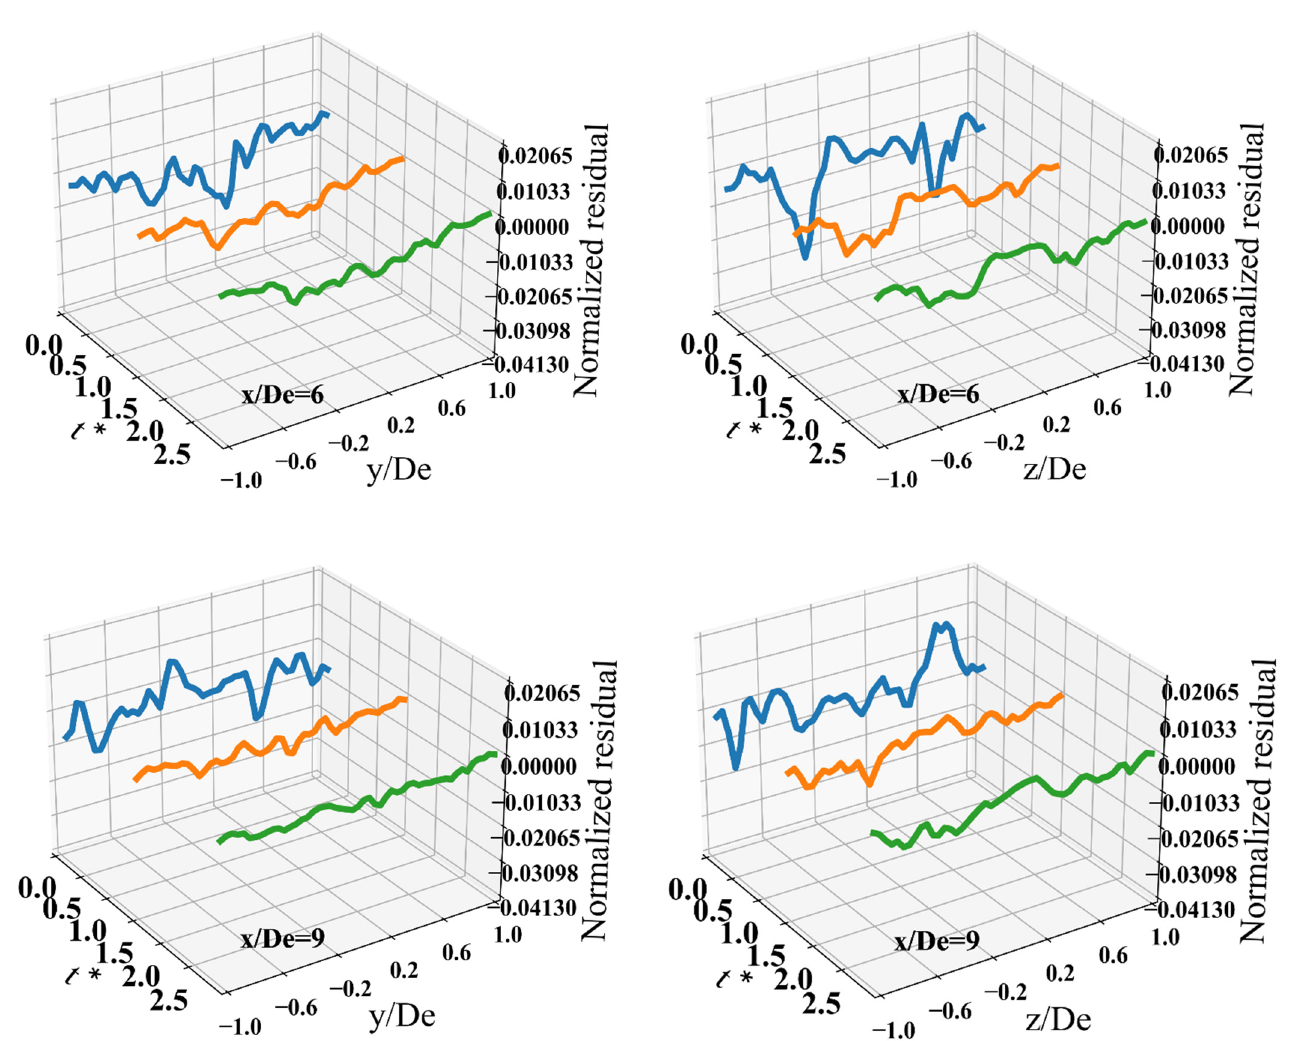
ρ j u 3 j ) along streamwise locations D e (cid:3096) (cid:3285) (cid:3048) (cid:3285)(cid:3119) ) along streamwise locations (cid:3005) (cid:3280)